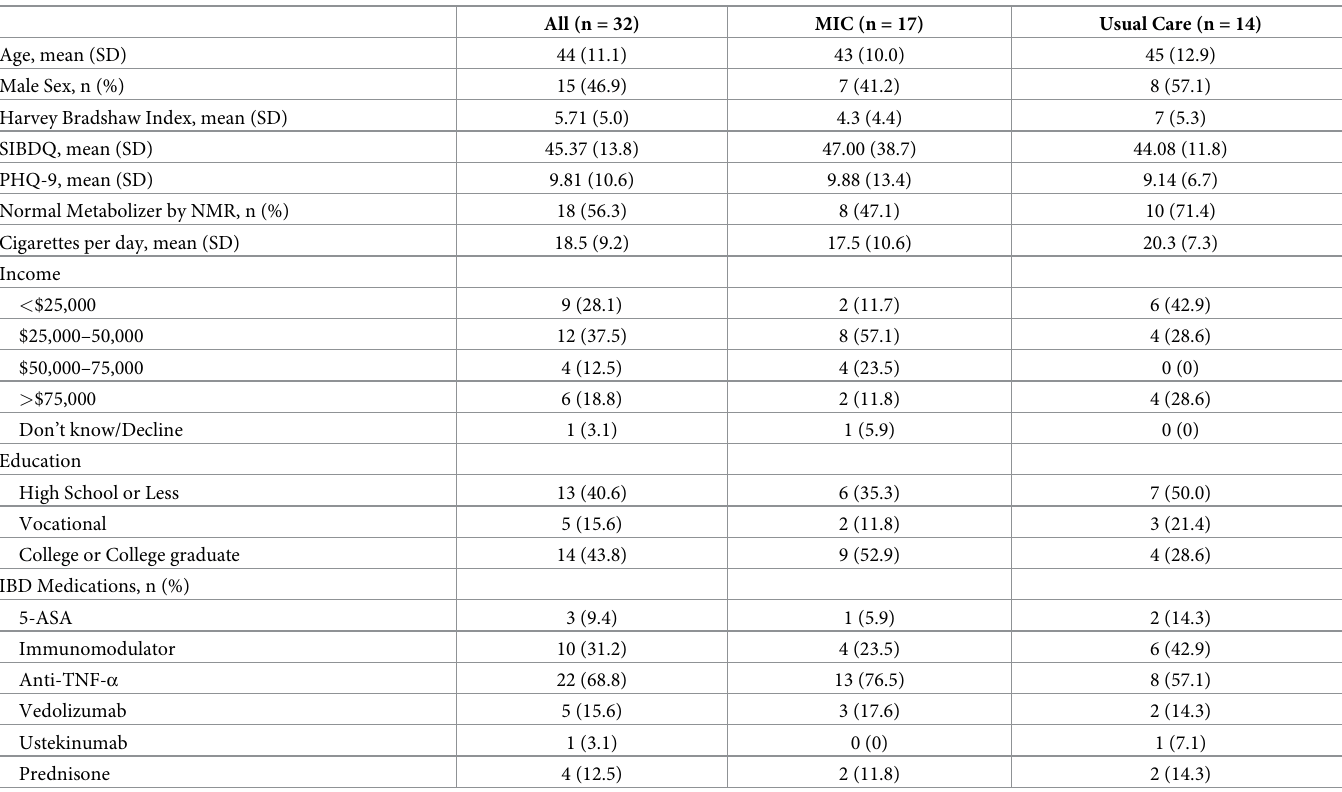
Table 2. Baseline characteristics of smoking cessation intervention participants.